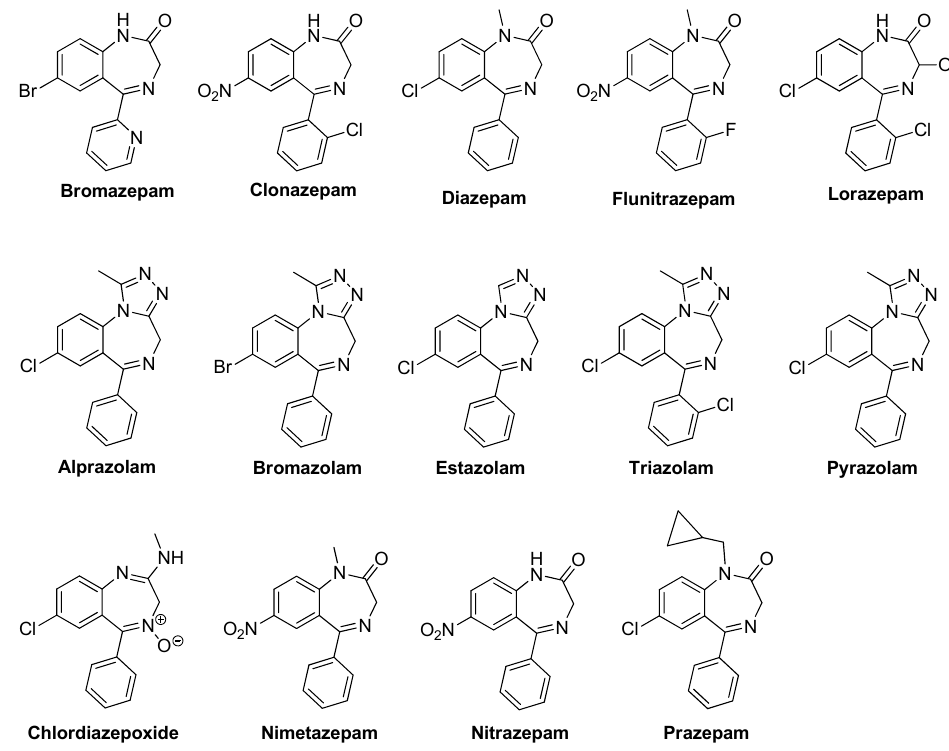
Figure 2. Some examples of BZDs that can be found on the market.